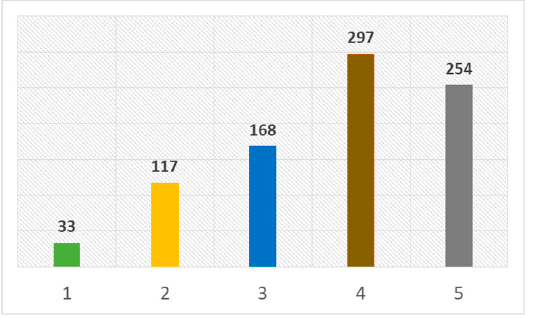
Figure 2. Total indications according to the used scale from 1 to 5 for all categories. Source: own research [73].